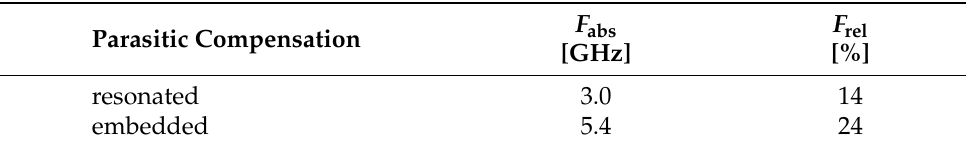
Table 6. Impact of the parasitic output capacitance of the transistors on the 25% bandwidth of a combined DPA in GaN, estimated by the simplified